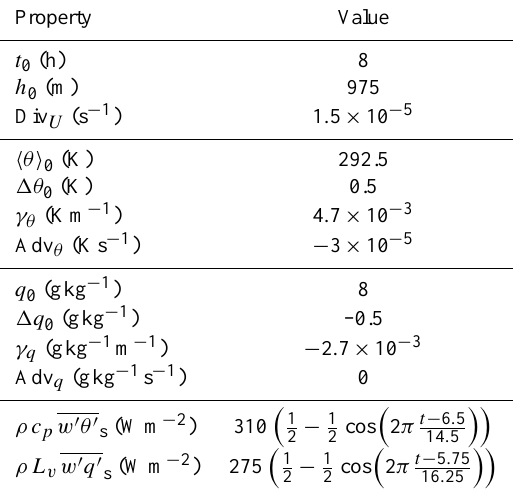
Table 3. Overview of the prescribed initial and boundary condi- tions. Presented are the initial values (subscript 0) for h , θ and q , the initial differences between the free troposphere and boundary layer (additional prefix 1 ) and the free tropospheric gradients (denoted by γ ) for θ and q , the surface fluxes (subsript s), the large scale divergence, Div U , and the advection of heat, Adv θ , and moisture, Adv q , for the MXL model. The time, t , is expressed in hours local daylight saving time. ρ = 1 . 2 kgm − 3 , c p = 1 . 0 × 10 3 Jkg − 1 K − 1 and L v = 2 . 5 × 10 6 Jkg − 1 . The MXL model is run for